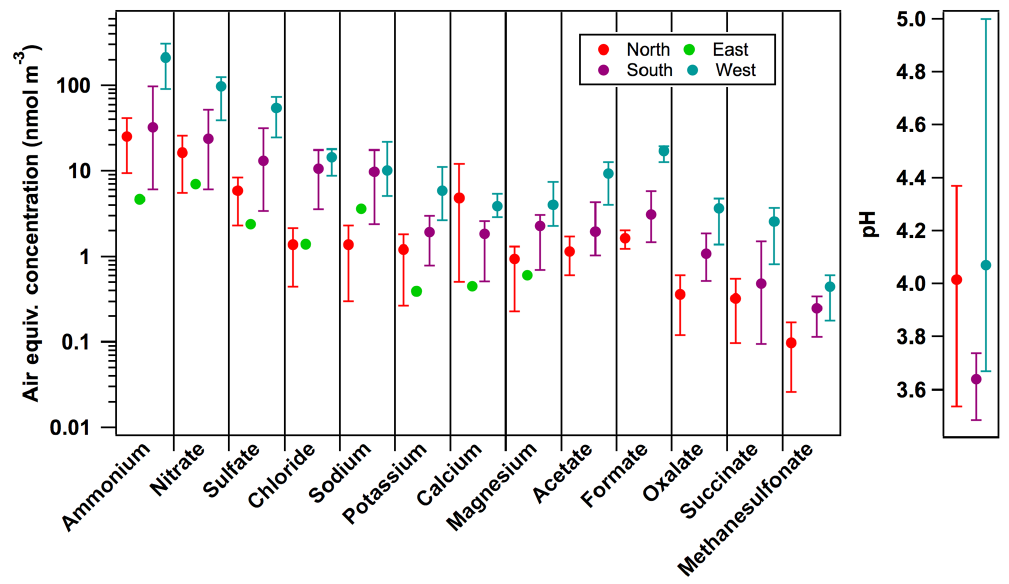
Figure 4. Sector analysis of most abundant inorganic fog water components, as well as selected organic acids. Highest concentrations of most species originated from the west. For Na + and Cl − , high concentrations were also observed from the south. Ca + 2 concentrations were also heightened within samples with northerly trajectories, which may suggest a continental dust source. In agreement with high measured NH + concentrations, pH was highest from the west. Note that samples were low in volume in some cases so that pH analyses were not 4 performed. For inorganic species except pH, n = 1 easterly, n = 3 northerly, n = 4 southerly, and n = 5 for westerly trajectories. For organic species and pH, n = 0 easterly, n = 2 northerly, n = 3 southerly, and n = 4 westerly.